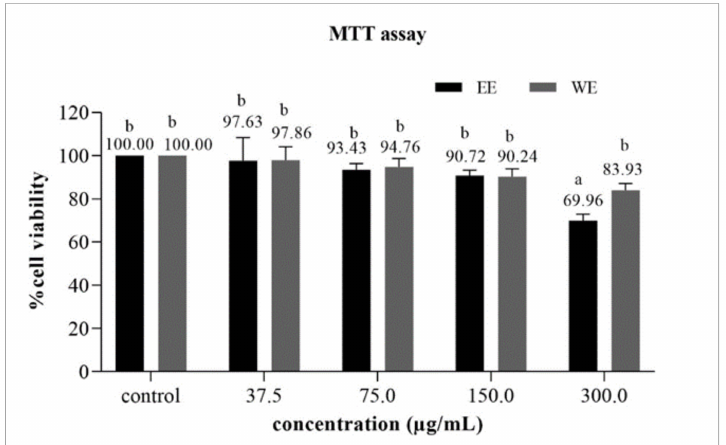
Figure 5. The cell viability of HaCaT cells treated with various concentrations of brown A. bisporus ethanol extract (EE) and brown A. bisporus water extract (WE) using MTT assay. Different letters above the columns in each extract indicate statistically significant differences ( p <